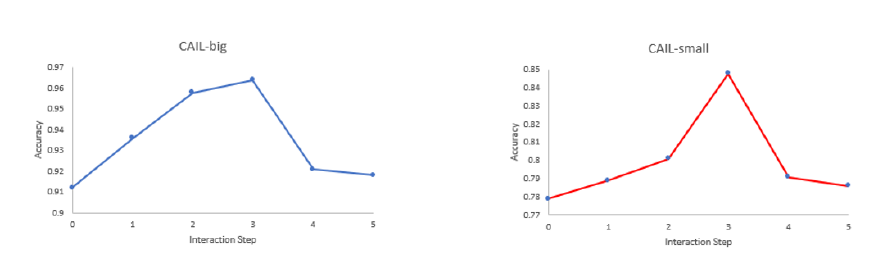
Figure 6. Effect of different numbers of interactions on